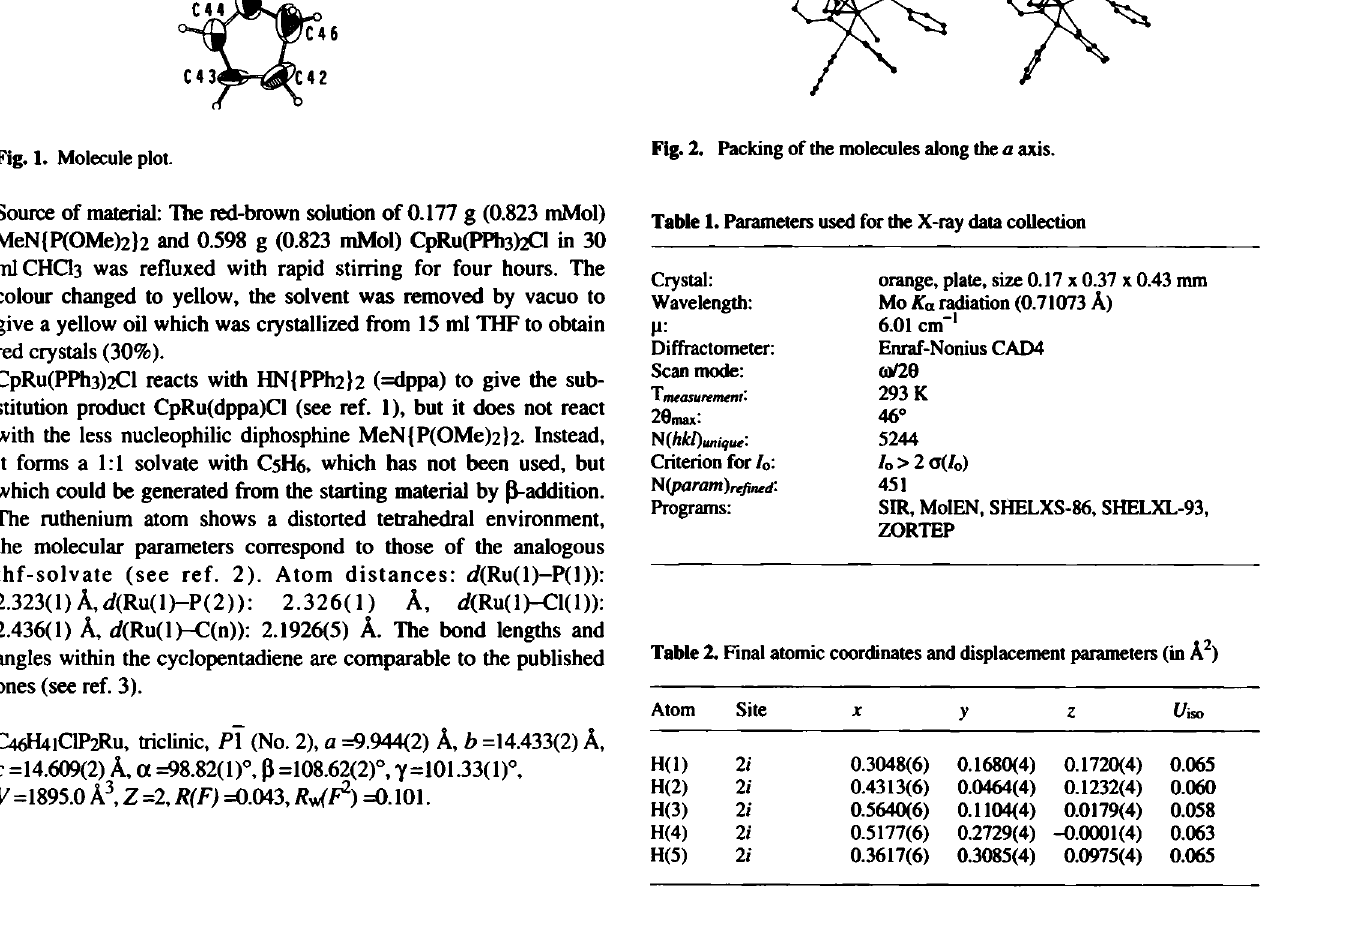
Fig. 1. Molecule plot. Fig. 2. Packing of the molecules along the a axis.